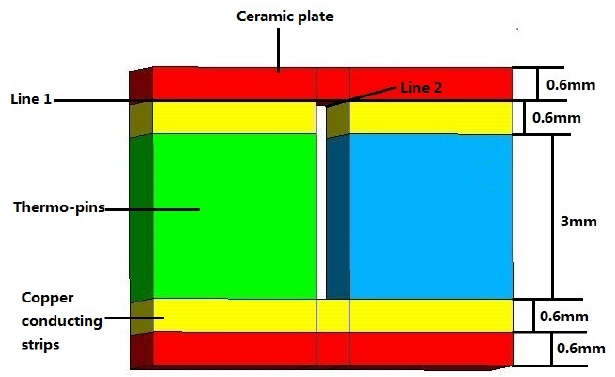
Figure 6. Front view of the referenced thermoelectric power generator.